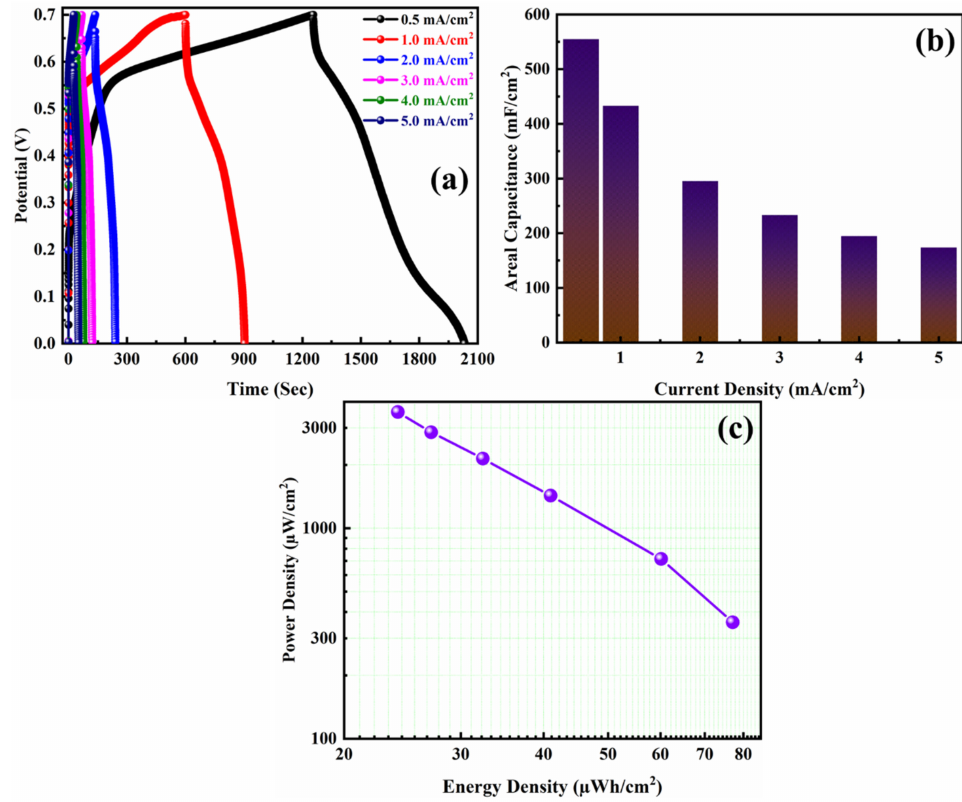
Figure 9. ( a ) GCD profiles at different current densities, ( b ) the corresponding areal capacitances obtained from the GCD profiles, and ( c ) Ragone plot of the PANI/NF//JAC/NF